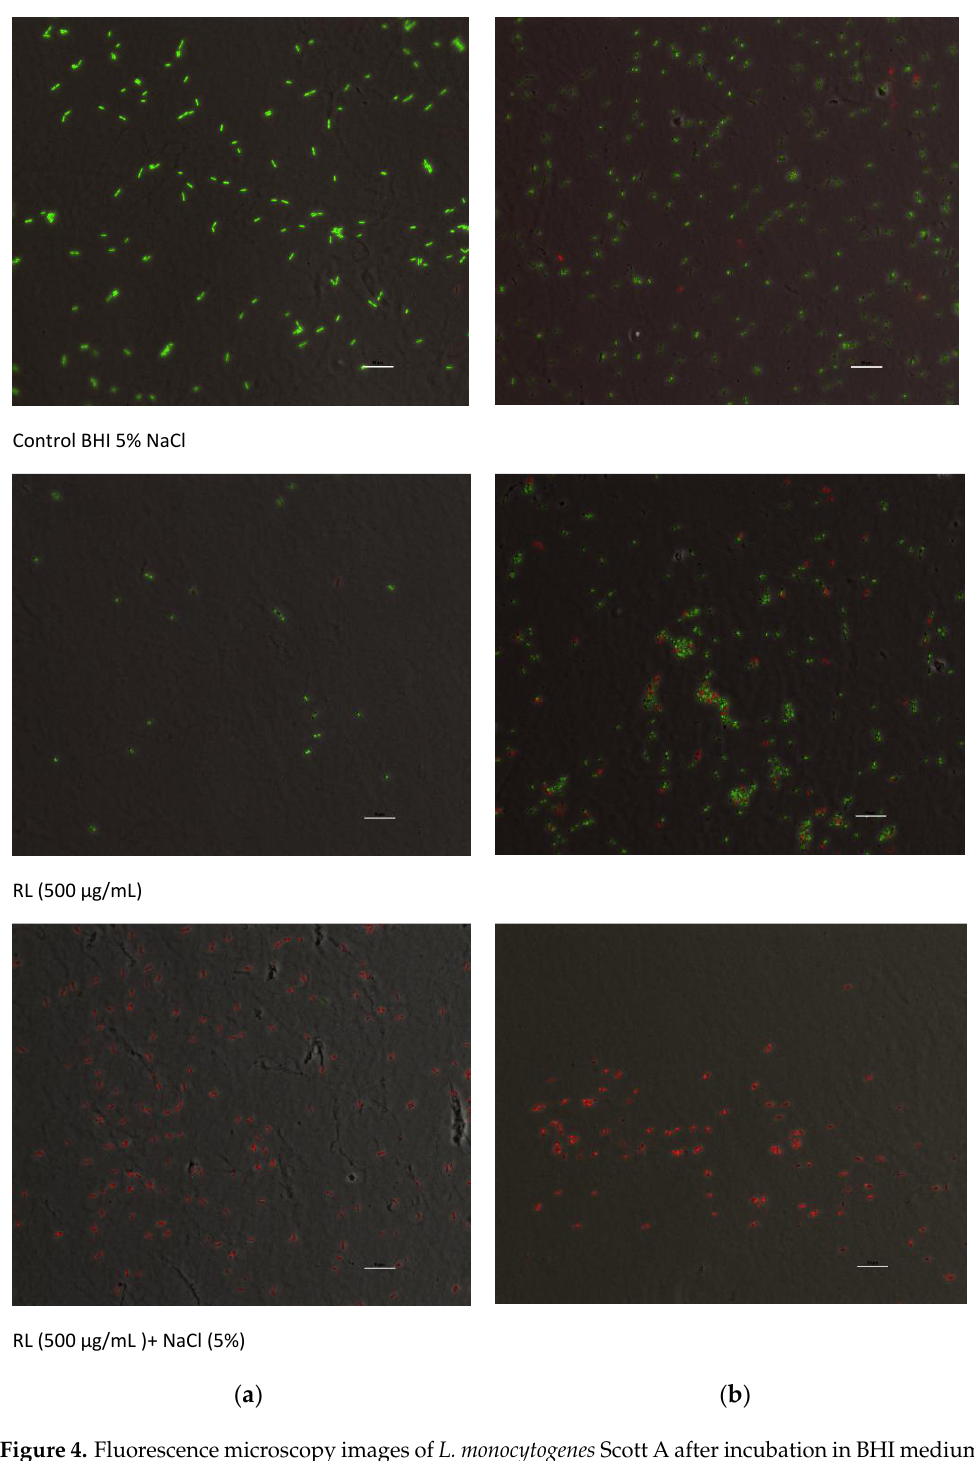
Figure 4. Fluorescence microscopy images of L. monocytogenes Scott A after incubation in BHI medium supplemented with NaCl (5%), rhamnolipids (500 µg/mL) and the combination of both for ( a ) 4 h and ( b ) 24 h at 30 °C. Green and red cells correspond to live and dead cells, respectively. Scale bar 10 µm.